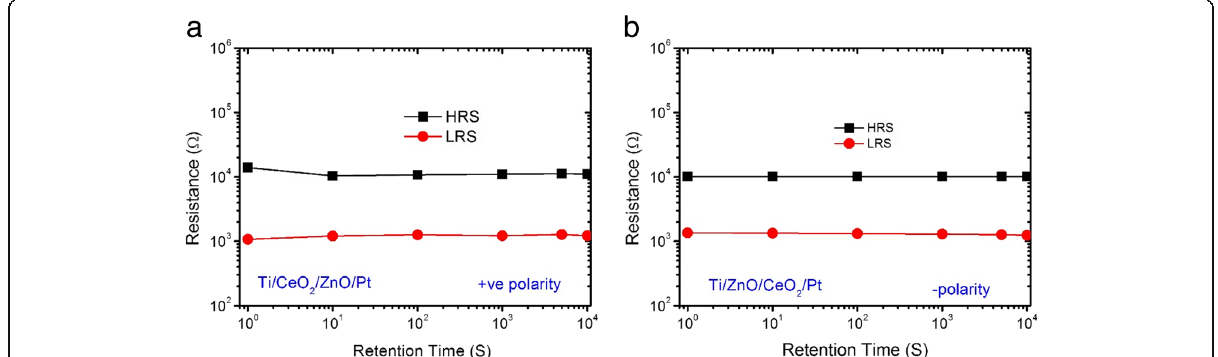
Fig. 5 Retention characteristics of a positively electroformed Ti/CeO 2 − x /ZnO/Pt heterostructure memory devices and b negatively electroformed Ti/ZnO/CeO